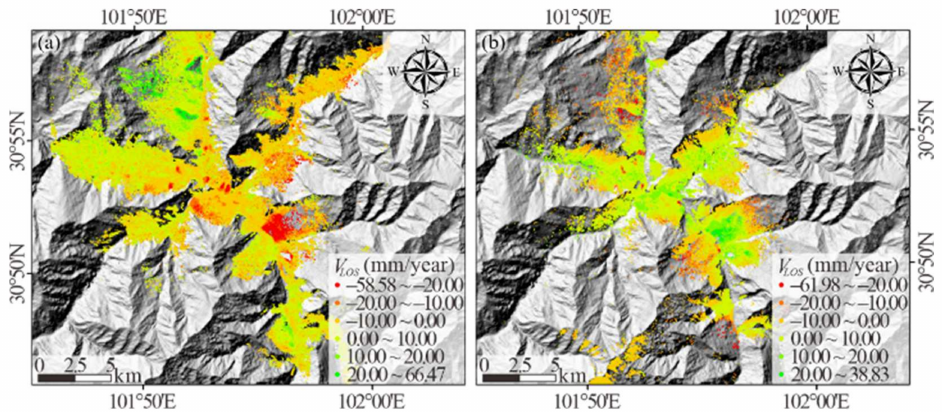
Figure 6. Ground surface deformation rate along the LOS direction V LOS in the study area obtained from the two SAR datasets: ( a ) Ascending Sentinel-1A dataset; ( b ) Descending Sentinel-1A dataset.